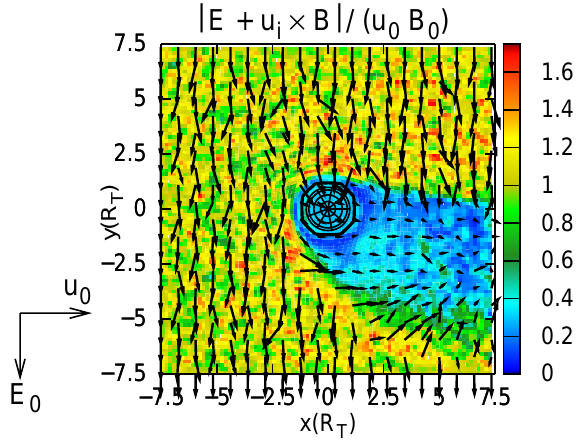
Fig. 12. Lorentz force acting on ionospheric ions (18:00 Saturnian local time). For a cut through the terminator plane, the figure dis- plays E + u i × B in normalized units. In regions where the iono- spheric density does not vanish, this quantity is the average Lorentz force acting on the ionospheric ions. In regions with n i ≈ 0, the quantity displayed in the figure is identical to the electric field. Since the Lorentz force is orientated perpendicular to the upper flank of the ionospheric tail and points inward the tail, it is responsi- ble for preventing the tail from expanding into the E − hemisphere. The figure also illustrates the acceleration of the ionospheric nitro- gen ions parallel to the direction of E × B ↑↑ u 0 at the tail’s outer flank in the E + hemisphere.